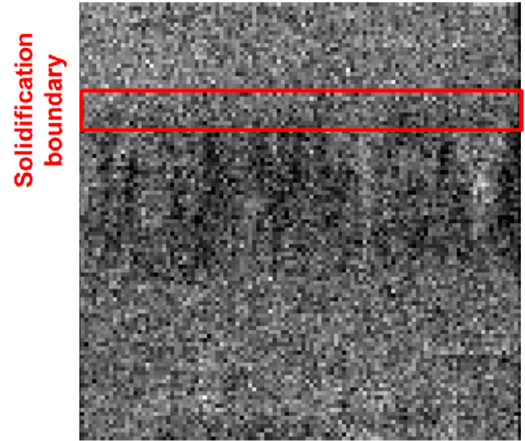
Figure 8. Neutron transmission imaging (80 mm × 80 mm) of the LBE sample during solidification (neutron wavelength: 0.530–0.537 nm; measurement time: 30 min). The red frame in the figure was considered the solid–liquid interface zone.